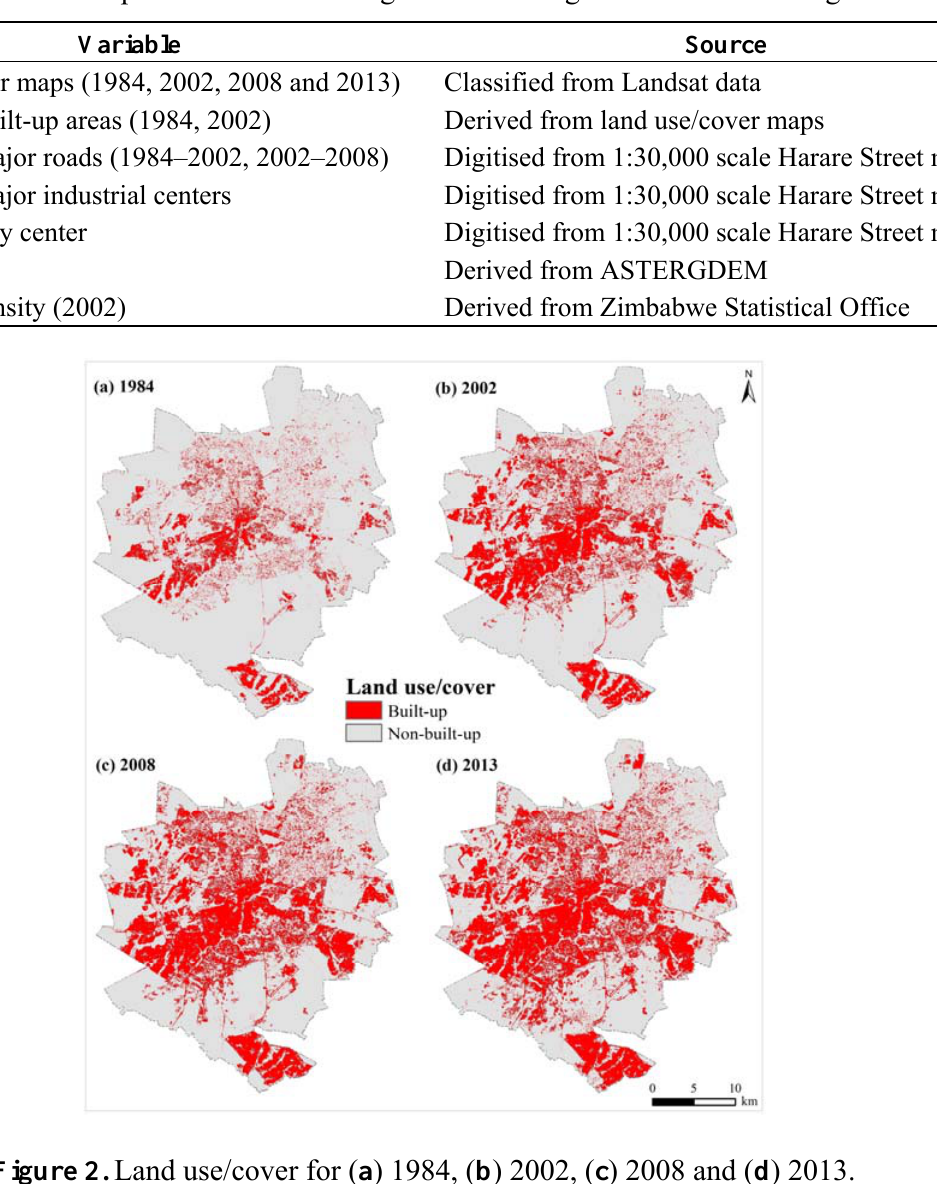
Figure 2. Land use/cover for ( a ) 1984, ( b ) 2002, ( c ) 2008 and ( d )